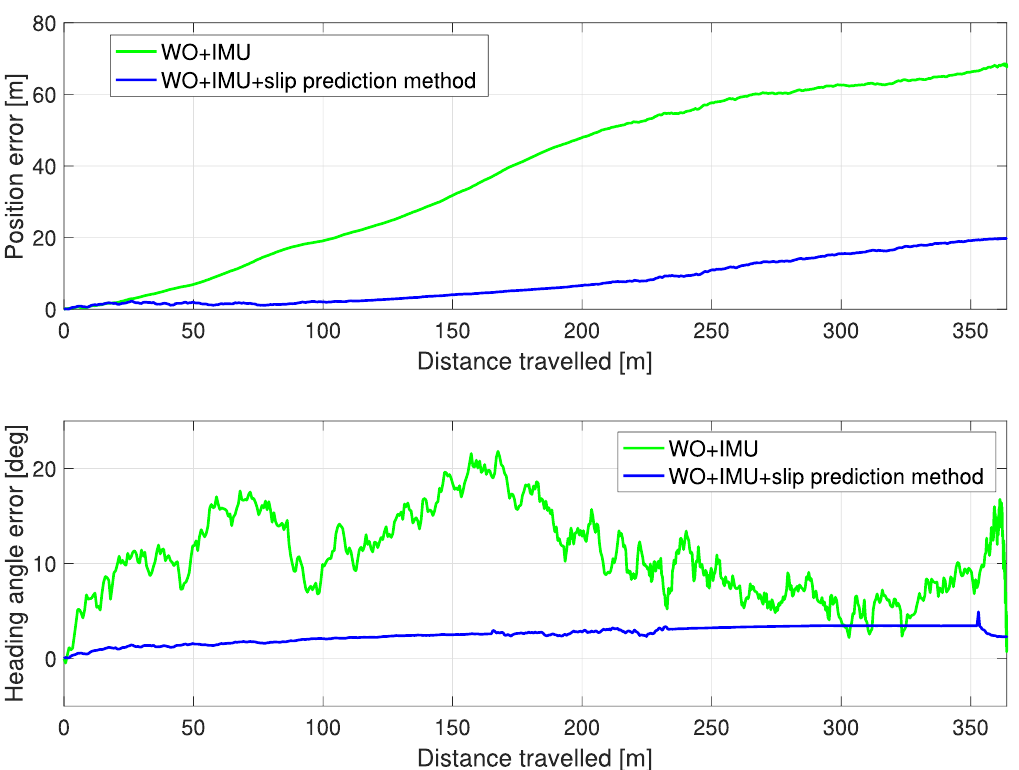
Figure 14. Comparison of the position error and heading angle error obtained through WO and IMU trajectory reconstruction and slip prediction method.